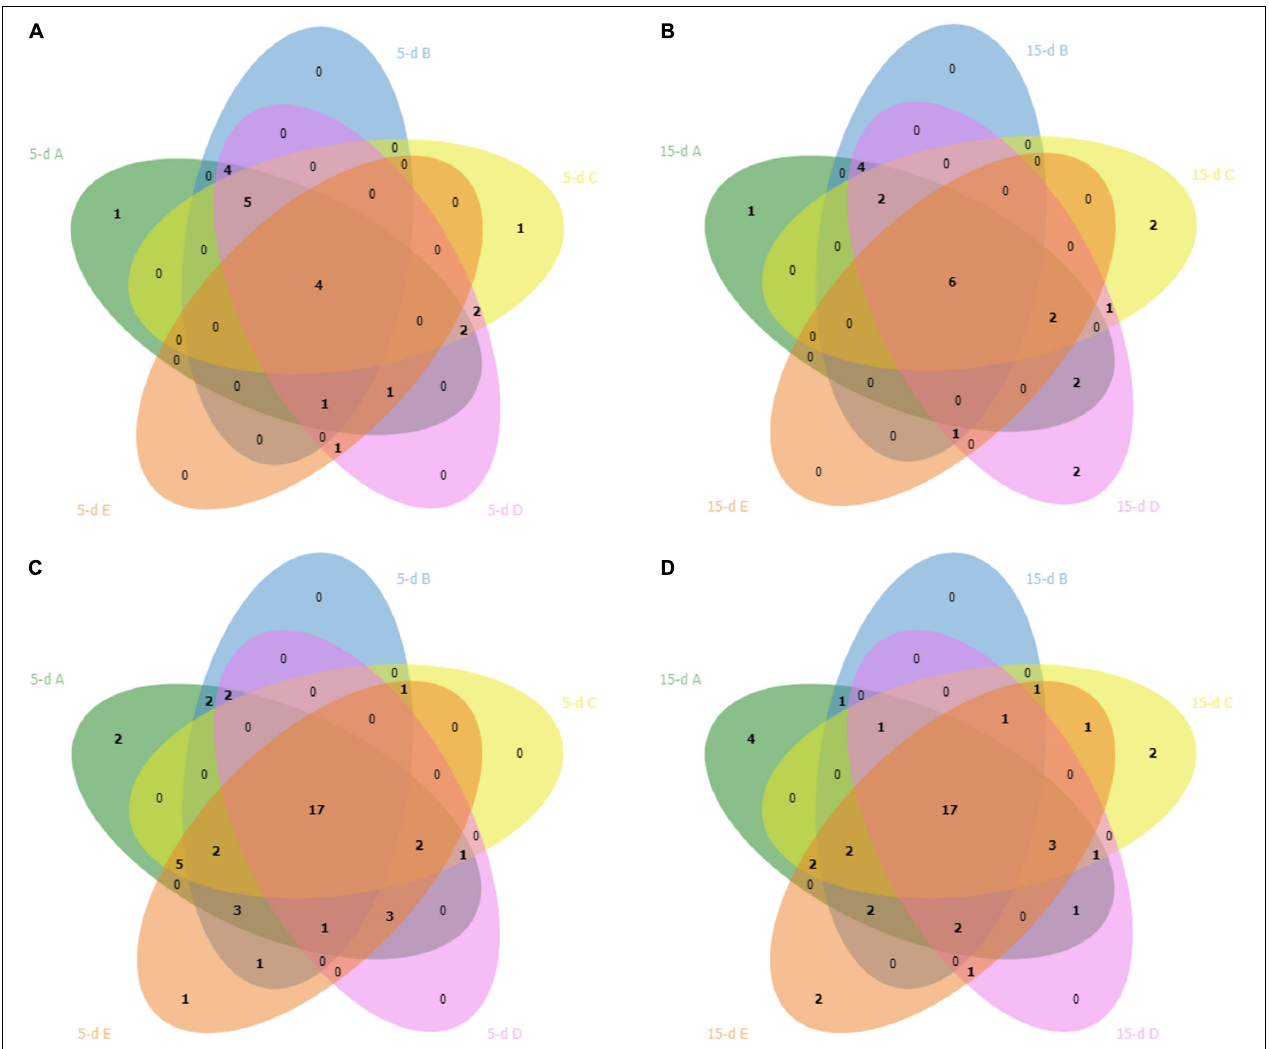
FIGURE 3 | Venn diagram shows overlap of bacterial ASVs in cheese after 5 days (5-d) of ripening (plot A ) and after 15 days (15-d) of ripening (plot B ) across the five dairy plants. Plots (C,D) showed the overlap of fungal ASVs in cheese after 5 and 15 days of ripening, respectively. The dairy plants names are indicated with the letter A (green), B (blue), C (yellow), D (pink) and E